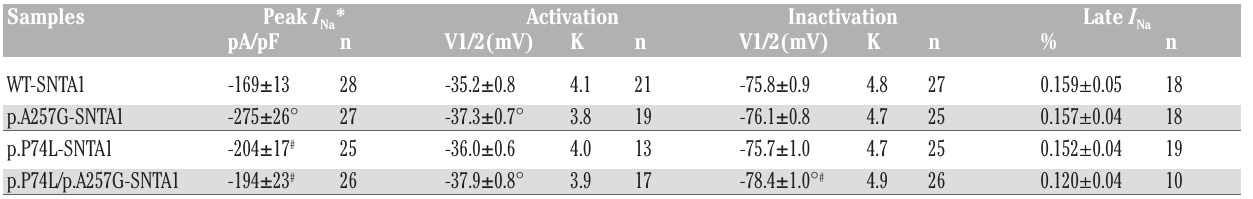
Table 1. Electrophysiological properties of sodium channels in HEK293 cells co-expressing SCN5A and SNTA1.